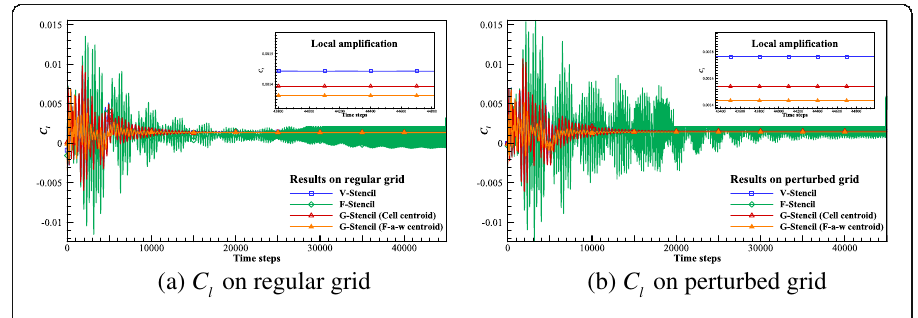
Fig. 29 C l on ( a ) regular and ( b ) perturbed triangular grids